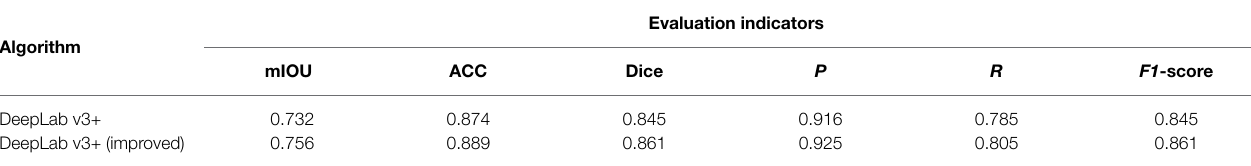
TABLE 3 | Statistics of the segmentation results of test set TS2 images before and after DeepLab v3+ improvement.